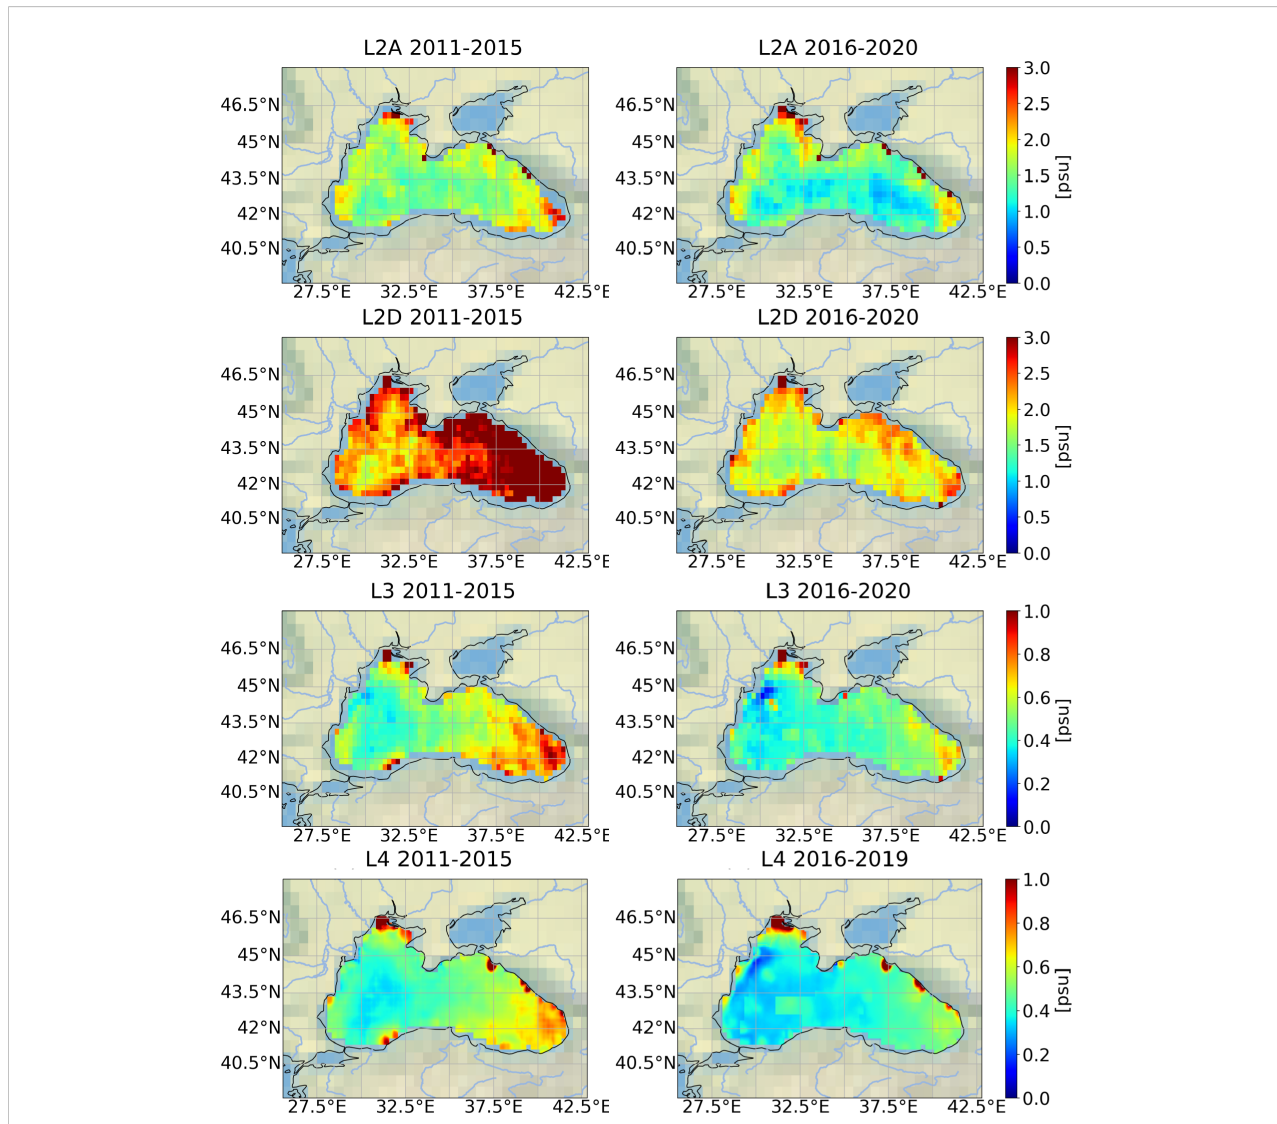
FIGURE 5 Spatial distribution of the uncertainty associated with the SSS product with respect to model simulations using the correlated triple collocation procedure for L2A ( fi rst row), L2B (second row), L3 (third row) and L4 (bottom) over 2011-2015 (left column) and 2016-2020 (right